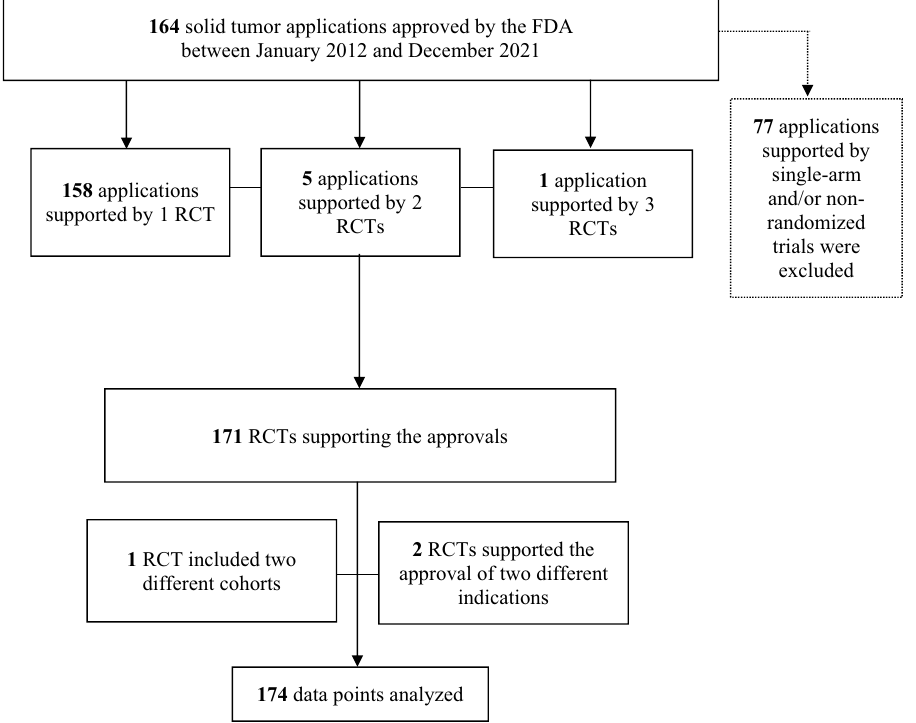
Figure 1. Summary of applications (n = 164), RCTs (n = 171) supporting the FDA application approvals and final data points (n = 174) analyzed in our study. RCTs Randomized Controlled Trials, FDA US Food and Drug